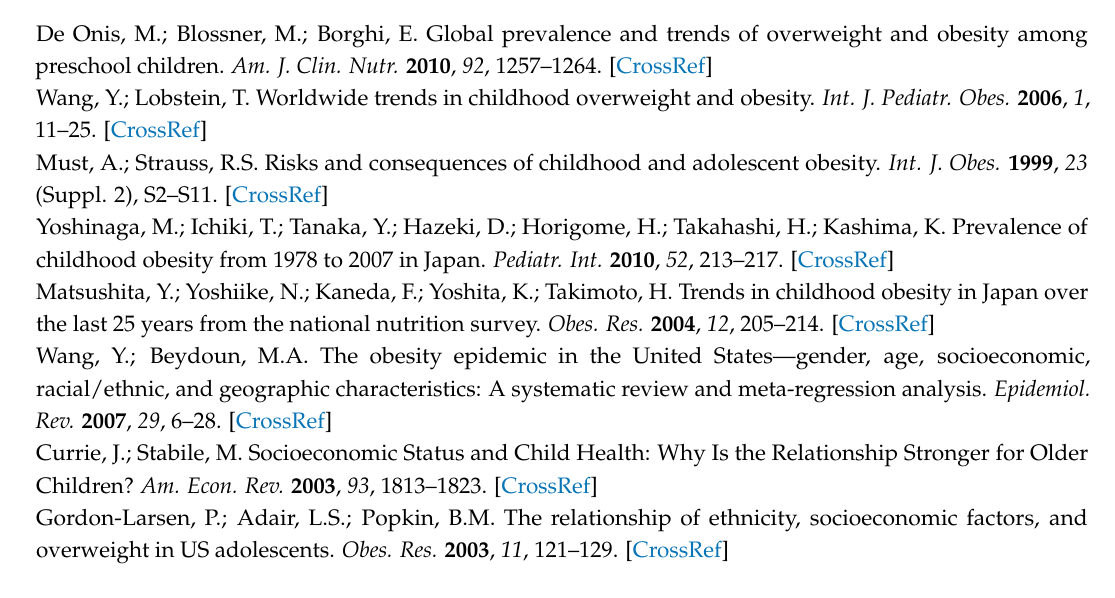
s1, Table S1: Odds ratio (OR) and 95% confidence interval (CI) for risk of overweight relative to normal weight by gender (Full results with estimated odds ratios and confidence intervals for the adjusted covariates), Table S2: Odds ratio (OR) and 95% confidence interval (CI) for risk of overweight relative to normal weight by gender and parental reception of social